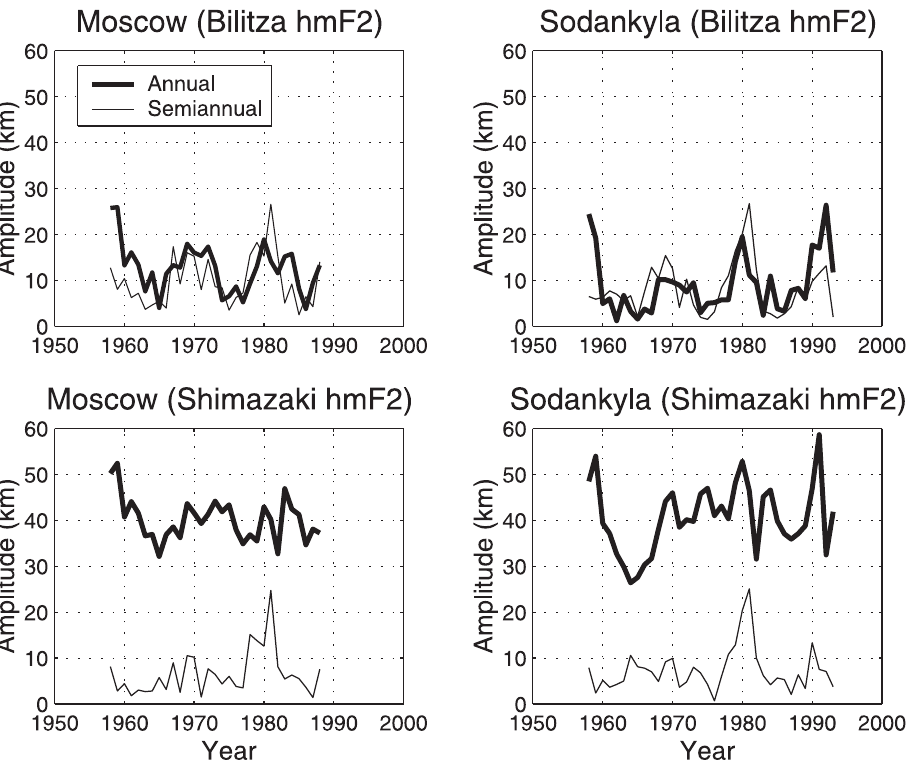
Fig. 3. Comparison of the am- plitudes of the annual and semi- annual components of h mF2, with (‘‘ Bilitza ’’) and without (‘‘ Shimazaki ’’) corrections for ionization underlying the F2-layer for day